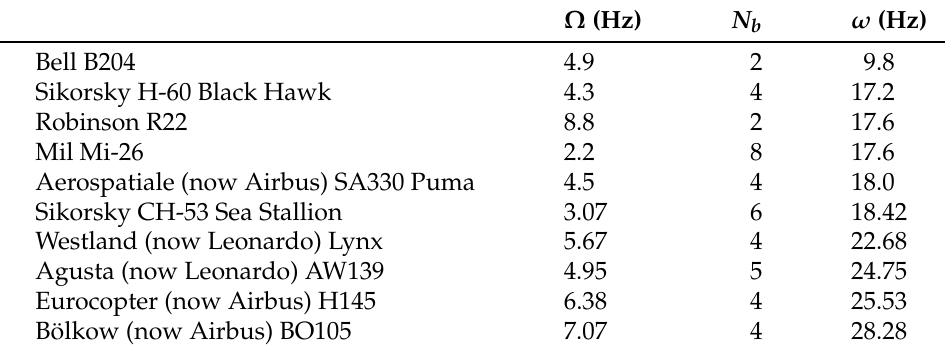
Table 1. Typical values of dominant frequency in helicopters, ω = N b Ω